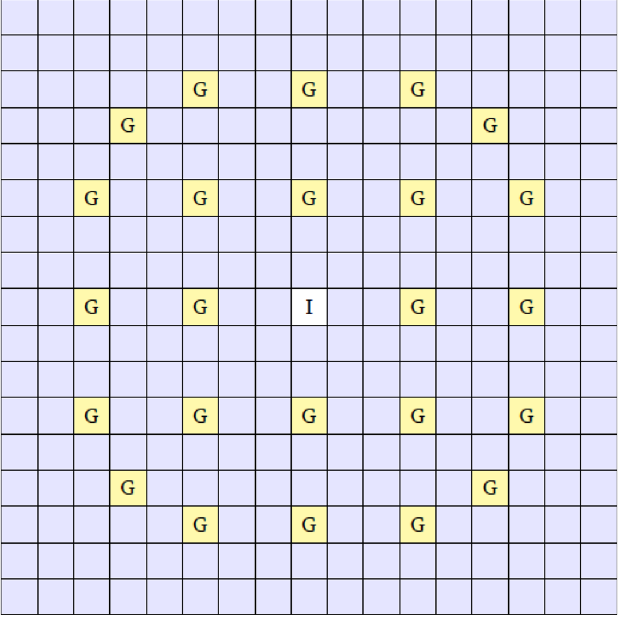
Fig. 3. Assembly without pyrex pin.